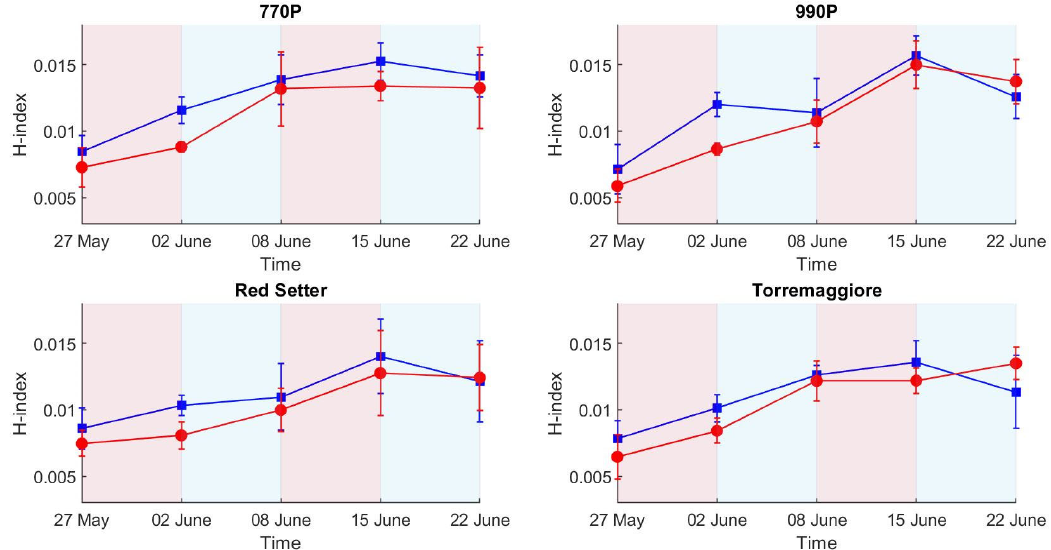
Figure 5. Hyperspectral index (H-index) values in stressed and control treatments (red and blue lines and points, respectively) for the four genotypes. Each point reports the mean of six samples and the associated standard deviation.